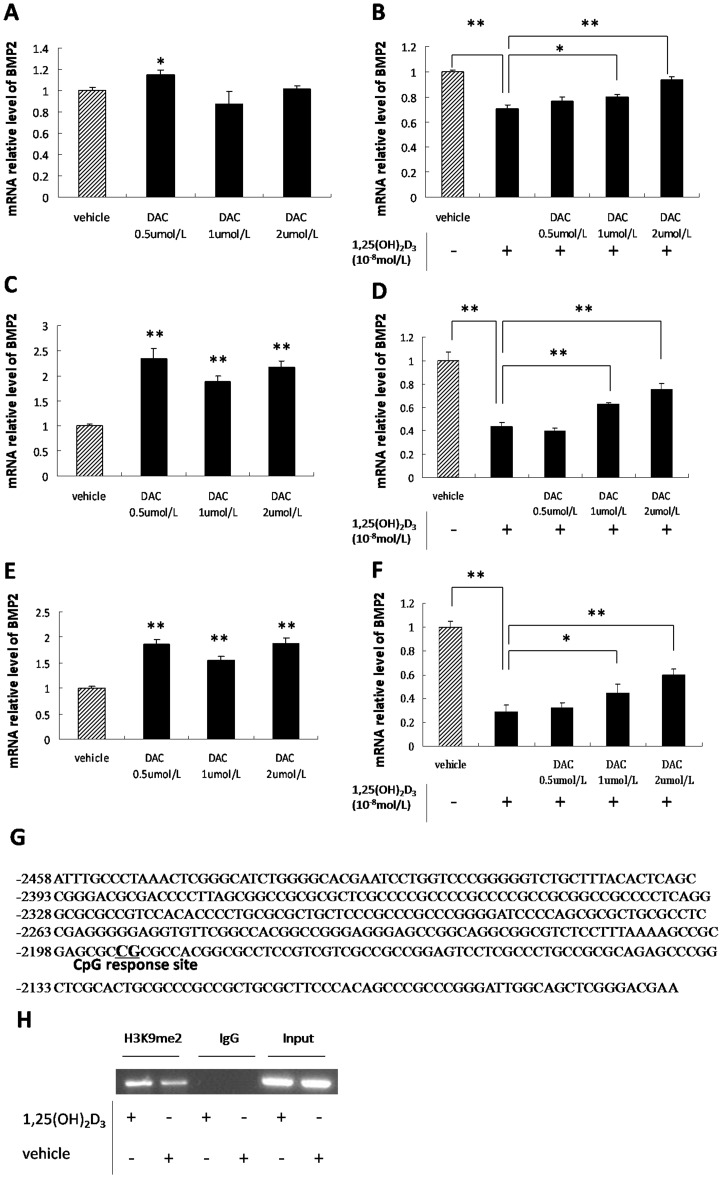
Activation of BMP2 expression by DAC.A. qRT-PCR of BMP2 expression in BMSCs from SD rats treated with varying concentration of DAC. B. qRT-PCR of BMP2 expression in BMSCs from SD rats treated with varying concentrations of DAC followed by 1,25(OH)2D3. C. qRT-PCR of BMP2 expression in BMSCs from GHS rats treated with varying concentrations of DAC. D. qRT-PCR of BMP2 expression in BMSCs from GHS rats treated with varying concentrations of DAC followed by incubation with 1,25(OH)2D3. E. qRT-PCR of BMP2 expression in UMR-106 cells treated with varying concentrations of DAC. F. qRT-PCR of BMP2 expression in UMR-106 cells treated with varying concentrations of DAC followed by 1,25(OH)2D3. G. Bisulfate sequencing of BMP2 promoter CpG island methylation in UMR-106 cells with 1,25(OH)2D3 administration and the CpG response site. The sequence is numbered relative to the translational start site. H. Antibody against H3K9me2 was used to do ChIP assay on chromatin extracted from UMR-106 cells which were incubated with 1,25(OH)2D3 or vehicle. The normal IgG was used as a negative control. Primer pairs designed for BMP2 promoter region C were used in the PCR. (*, P<0.05; **,P<0.01).